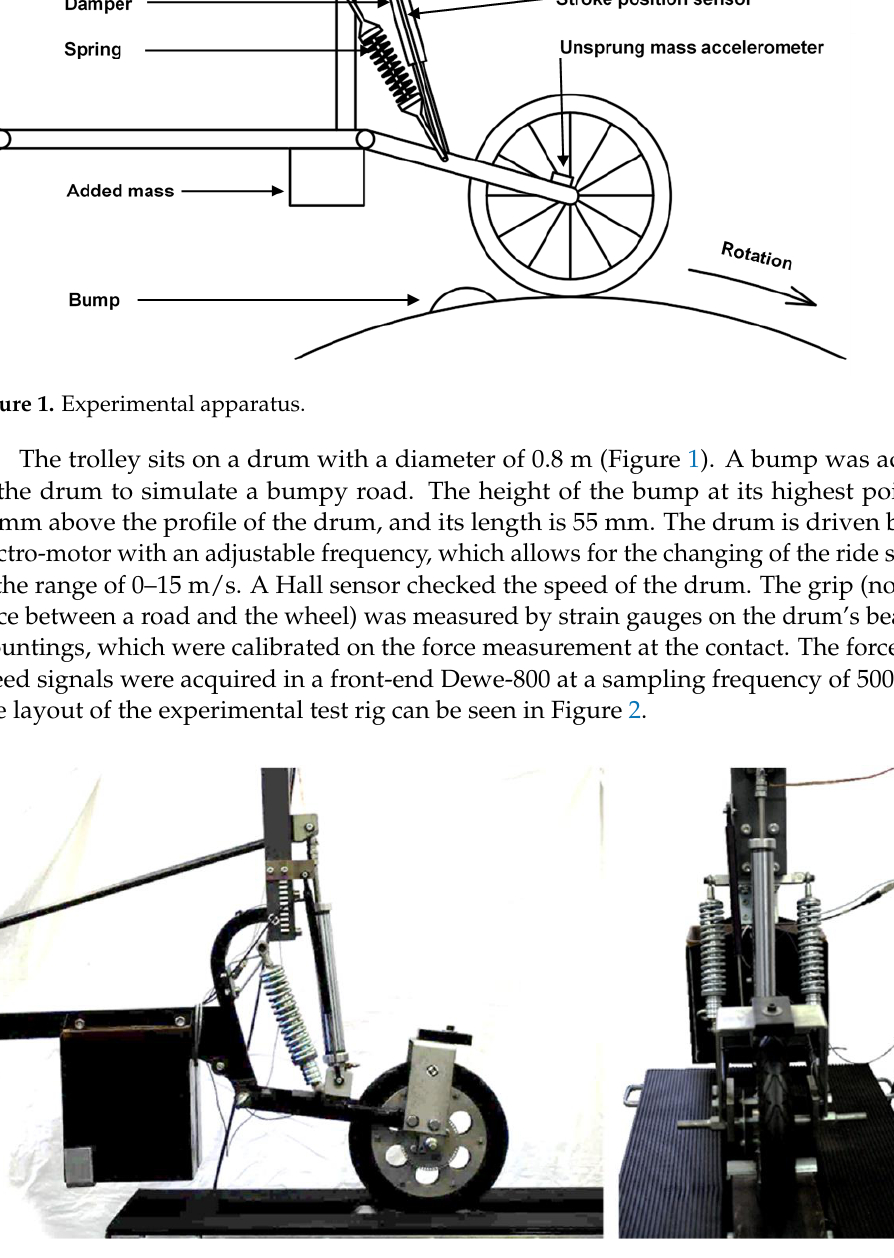
Figure 2. The trolley on the drum.